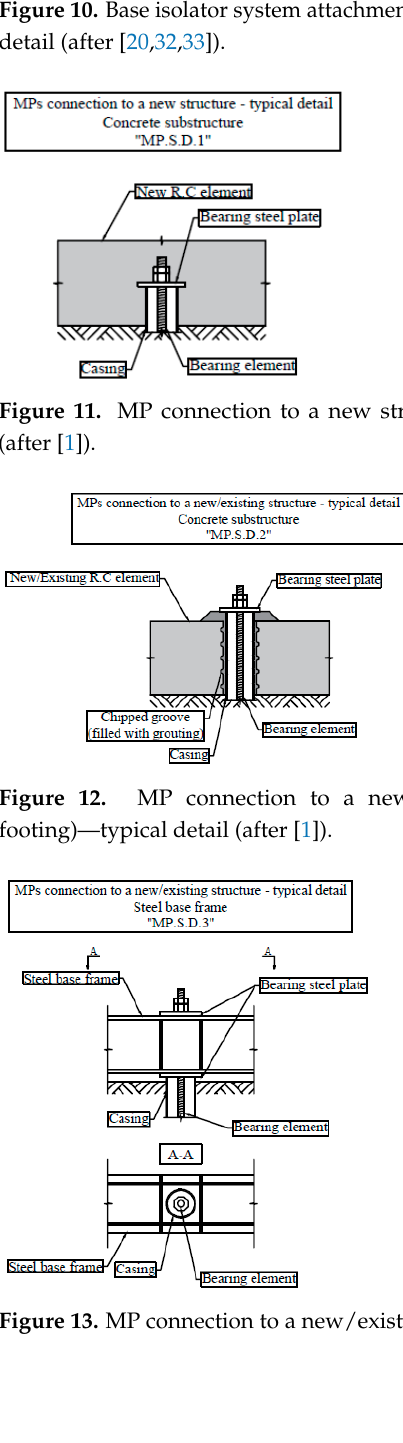
Figure 14. New proposed detail for combing MPs with BIS (new reinforced concrete footing).